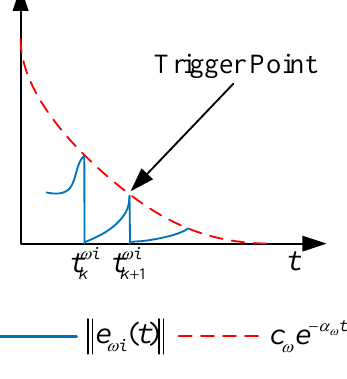
Figure 2. Trigger time.